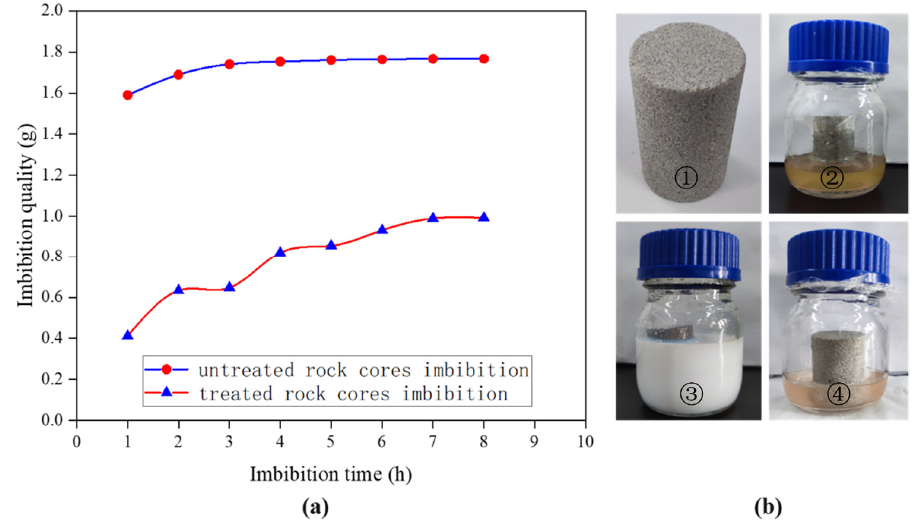
Figure 9. ( a ) Comparison of the spontaneous imbibition water quality of the core before and after wettability alteration. ( b ) Spontaneous imbibition experiment. ① The dry core before wettability modification. ② Spontaneous imbibition experiment of the tight sand core before wettability mod ‐ ification. ③ The same core soaked in the superhydrophobic fluorinated nanofluids. ④ Spontaneous imbibition experiment of the same tight sand core after wettability modification.